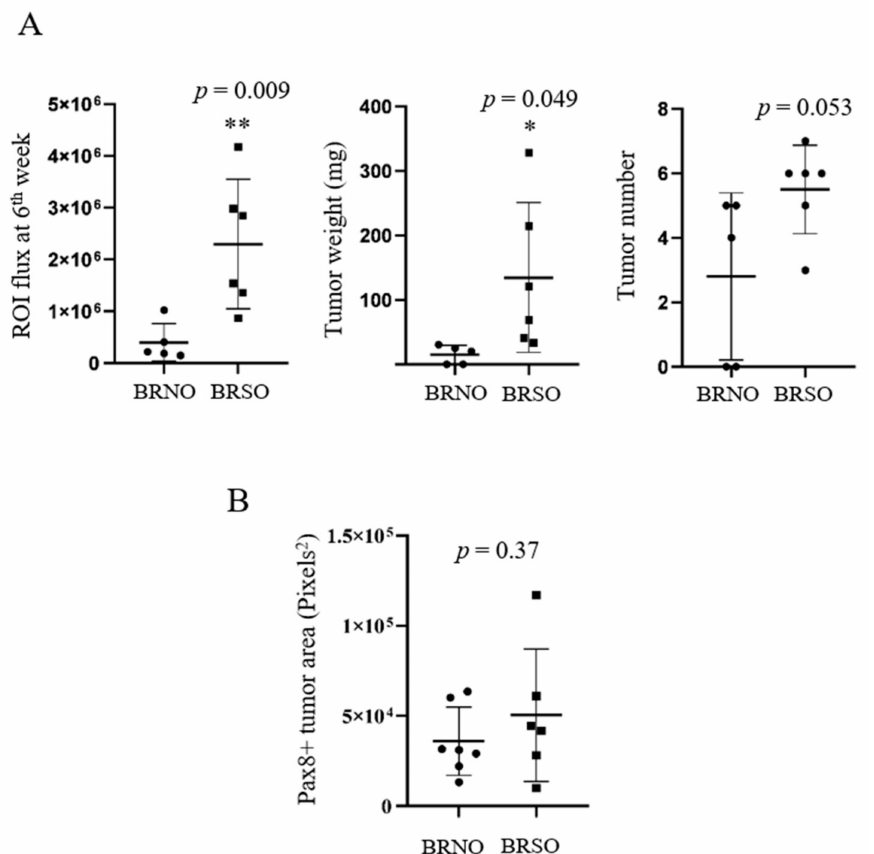
Figure 4. Compared to normal ovulation, superovulation resulted in an increase in peritoneal seedings but not local ovarian seeding of transformed FTE cells. ( A ) IVIS ROI flux signals, tumor weight, and tumor number measured in the sixth week after i.p. xenograft in different groups. BR: Bursa − removed, BI: Bursa-intact, NO: Normal ovulation, SO: Superovulation. * p < 0.05, ** p < 0.01, by two-sided, unpaired Student’s t -test. ( B ) PAX8-expressing tumor area in bursa-removed mice with or without superovulation.* p < 0.05, ** p < 0.01, by two − sided, unpaired Student’s t